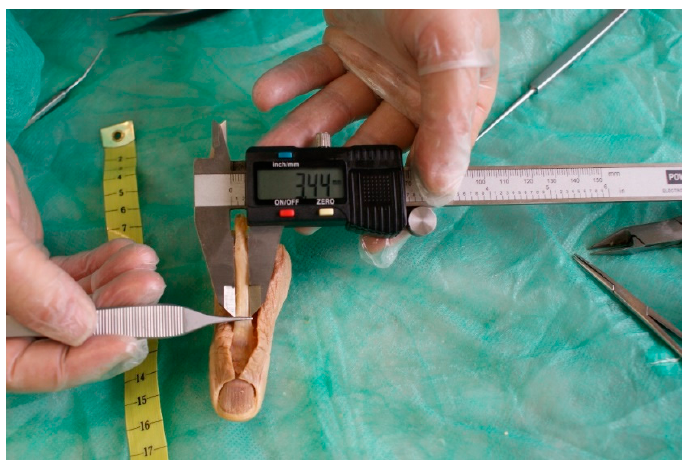
Figure 1. Exposing the nail matrix, the distal interphalangeal joint, and the terminal extensor pollicis longus tendon.